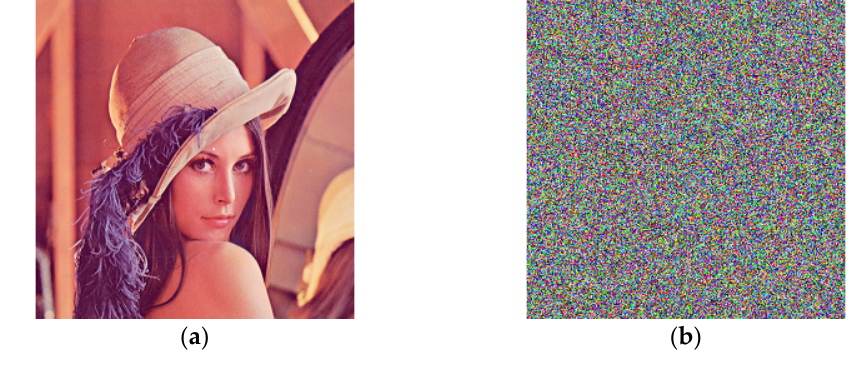
Figure 10. Key sensitivity test, ( a ) correct key, ( b ) wrong key.